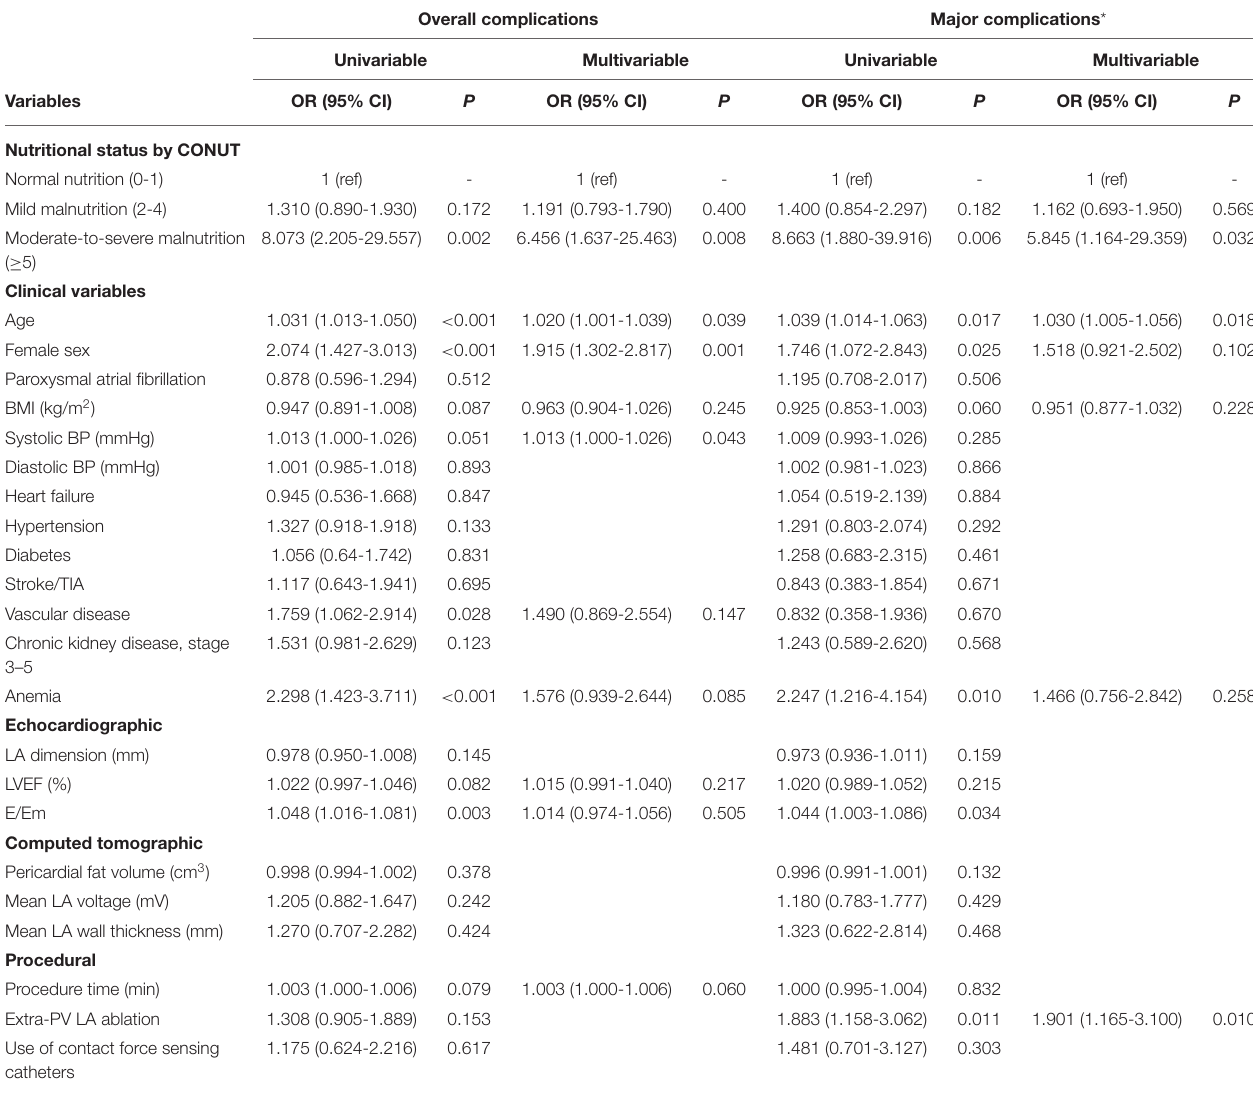
TABLE 4 | Logistic regression analysis for the predictors of the overall and major complications. Overall complications Major complications * Univariable Multivariable Univariable